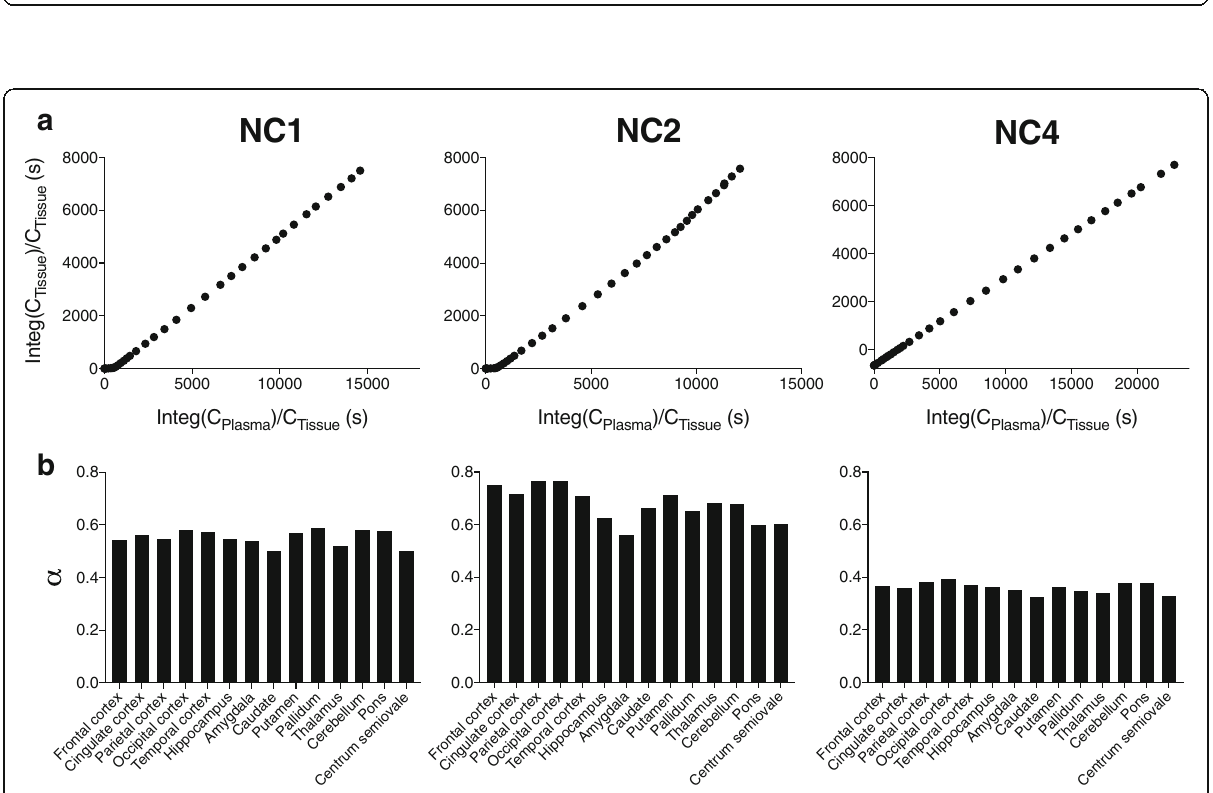
Fig. 4 a Logan plots with parent input functions in the frontal cortex in three subjects. b Regional total distribution volumes ( V T s) determined by Logan plots with parent input functions in three subjects